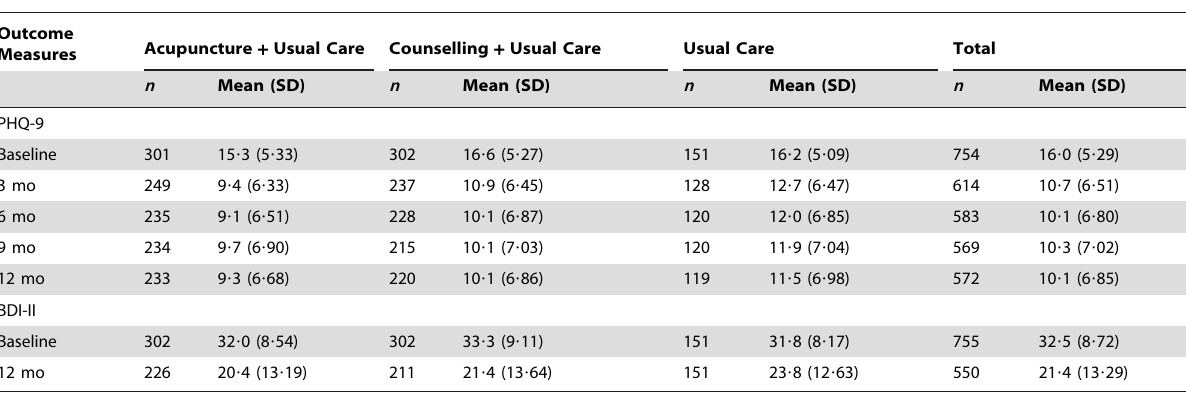
Table 2. Unadjusted depression